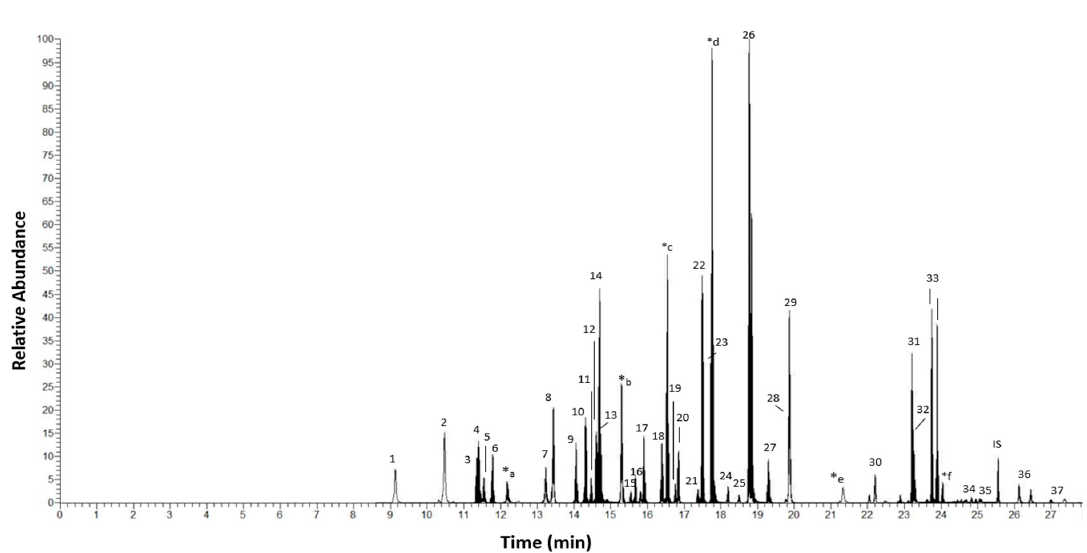
Figure 1. Chromatographic separation of a mixed standard solution of (1) tecnazene, (2) α‐ HCH, (3) β‐ HCH, (4) γ‐ HCH,